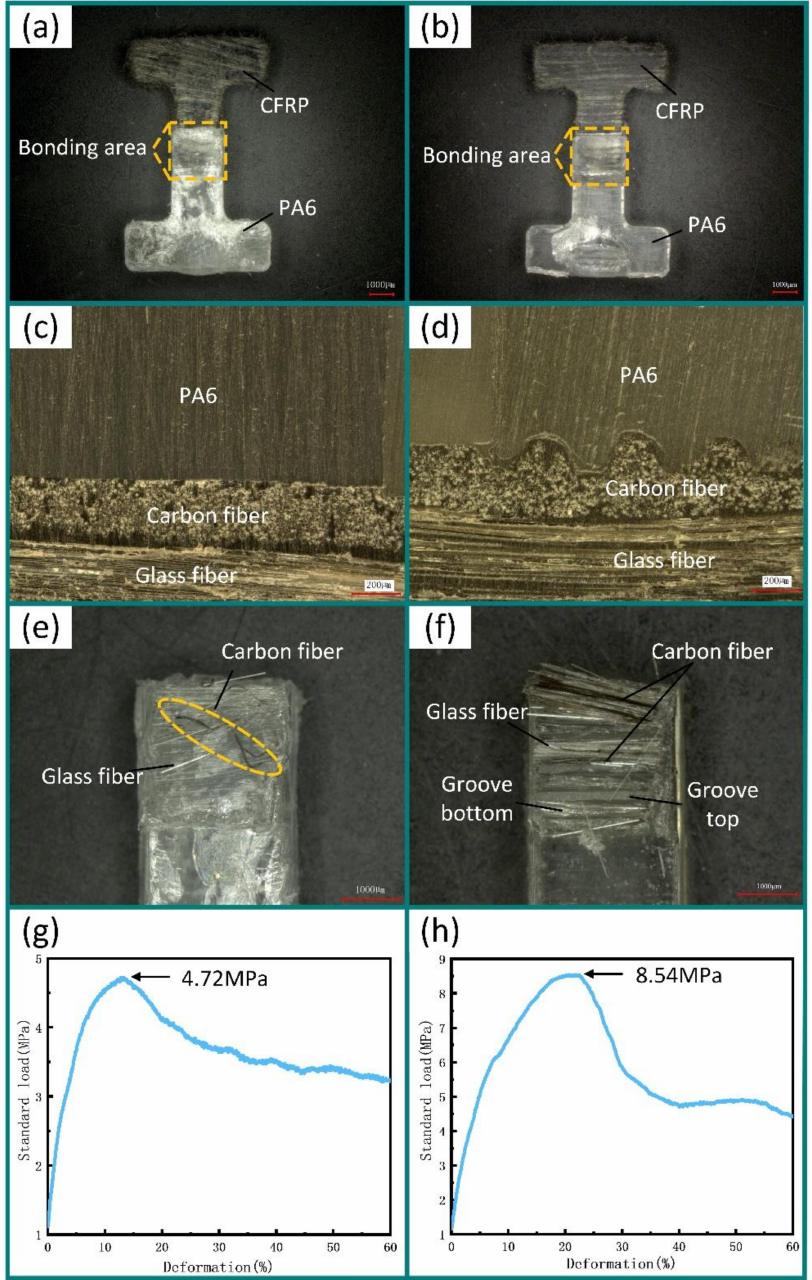
Figure 8. ( a ) Composite part without micro-grooves; ( b ) composite part with micro-grooves; ( c ) con- nection interface of the composite part without micro-grooves; ( d ) connection interface of the compos- ite part with micro-grooves; ( e ) tensile fracture surface of the composite part without micro-grooves; ( f ) tensile fracture surface of the composite part with micro-grooves; ( g ) tensile strength of the composite part without micro-grooves; ( h ) tensile strength of the composite part with